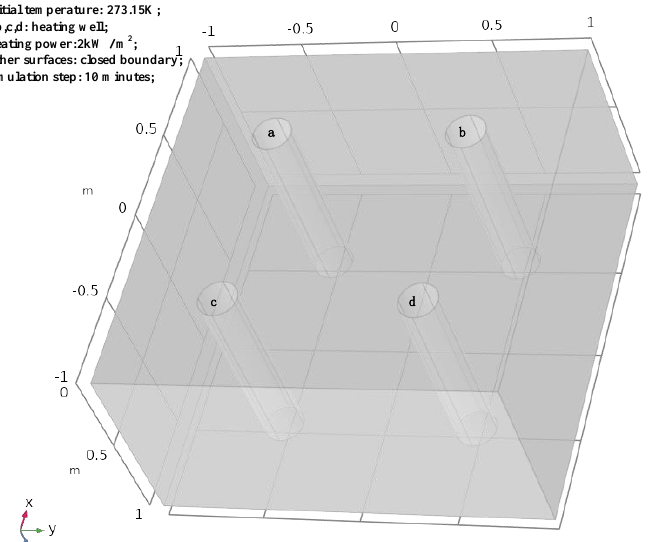
Figure 1. Heat transfer model of porous media. There is no fluid flow and heat exchange on the closed boundary. Considering that many cells are closely distributed in the heating site, the four planes on the outside parallel to the axis of the heating well are periodic boundaries.